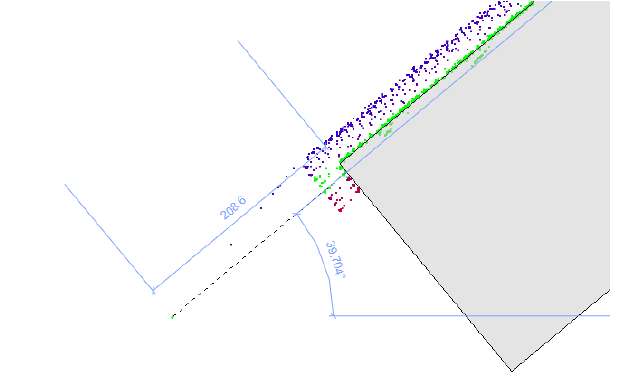
Figure 10. Noise that caused over-extension from the static corridor scan data shown against reference